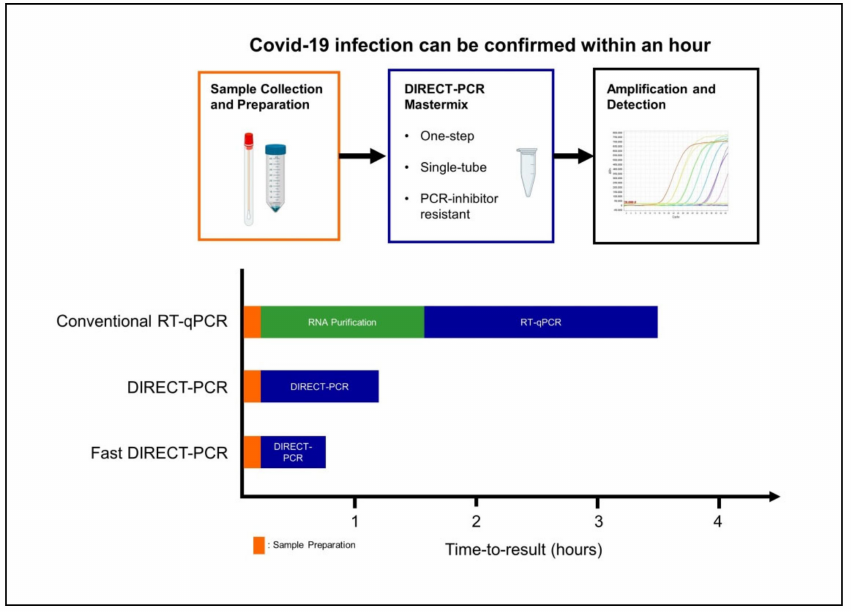
Figure 3. Workflow of fast DIRECT-PCR protocol for the direct detection of SARS-CoV-2. Covid-19 infection can be confirmed in less than an hour after sample collection and addition to mastermix for amplification and